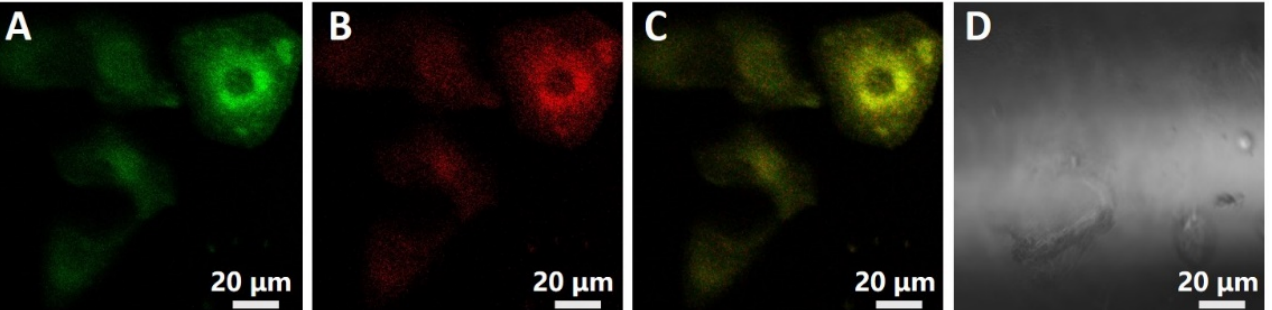
Figure 9. Confocal laser scanning microscopy of HeLa cells co-stained with mPEG-b-P(PA-alt-AG- ERh) nanosensor (5 μ M) and LysoSensors Green DND-189 (1 μ M). ( A ) Green emission of LysoSensors Green DND-189; ( B ) Red emission of mPEG-b-P(PA-alt-AGERh) nanosensor; ( C ) overlay of ( A ) and ( B ); and ( D ) a bright field image. Excitation wavelength of mPEG-b-P(PA-alt-AGERh) nanosensor and LysoSensors Green DND-189 was 560 nm and 488 nm, respectively.